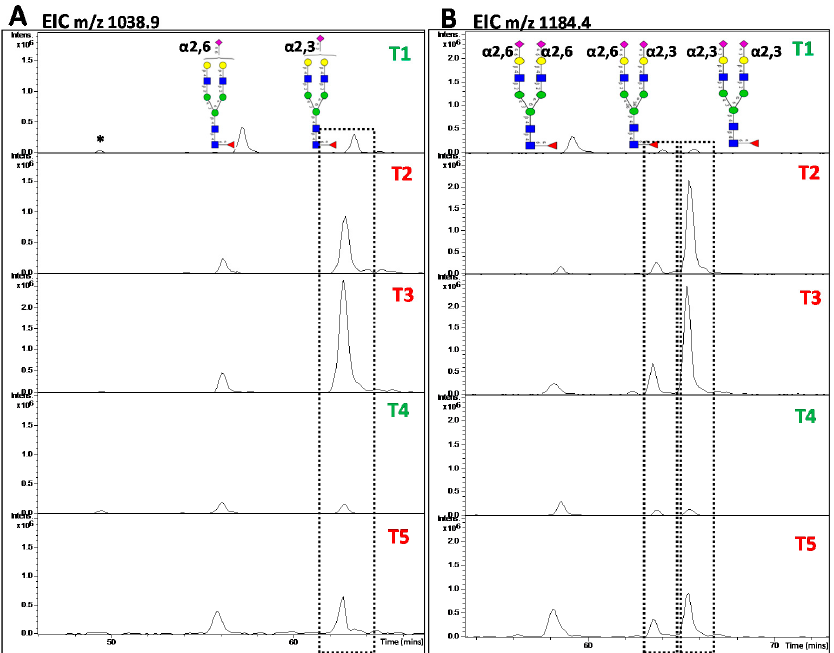
Figure 3. Extracted Ion Chromatograms (EIC) for mono- and di-sialylated biantennary complex type N -glycans ( A ) m / z 1038.9 2 − and ( B ) m / z 1184.4 2 − showing the separation power of PGC for α 2,3 and α 2,6-sialylation. Different ratios for α 2,3 and α 2,6-sialylation were observed between EGFR + CRC (green, T1,T4) and EGFR − CRC tissues (red, T2, T3 and T5) [57]. *, a low abundant glycan isomer.